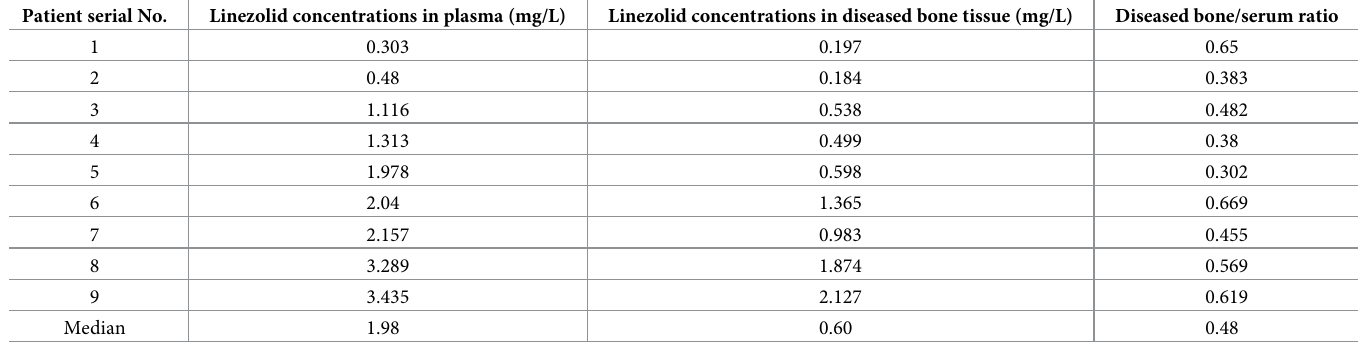
Table 2. Plasma and bone concentrations of linezolid 24 h after administration for each patient. Patient serial